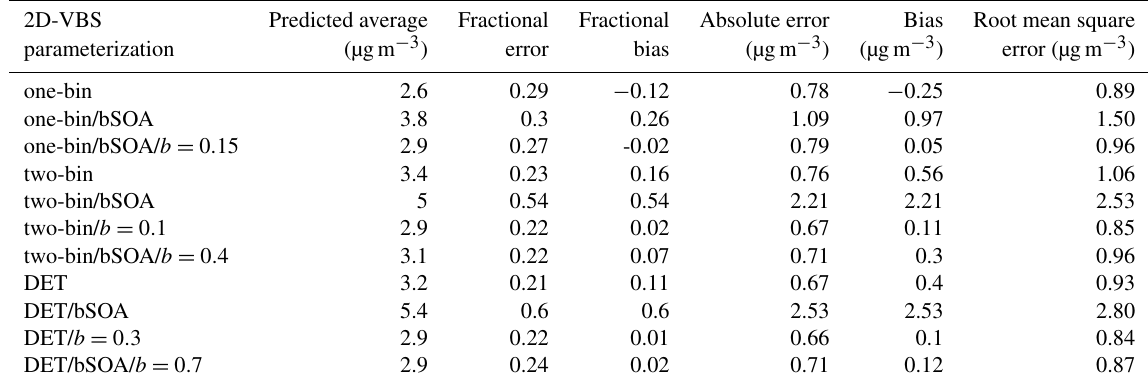
Table 3. Performance metrics of different parameterizations during the PEGASOS campaign for ground OA mass measurements. The measured average organic aerosol concentration was 2.8µgm − 3 .